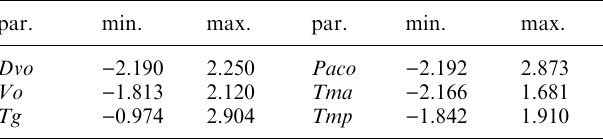
Table 1. Fluctuation range of parameters during the observational period par. min. max. par.